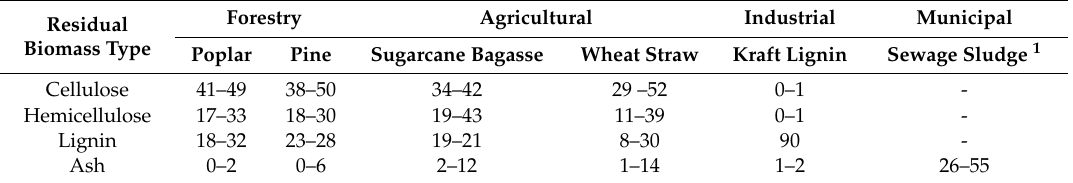
Table 1. Lignocellulosic biomass and distribution of cellulose, hemicellulose, lignin, and ash (wt%) on a water-free basis [26].